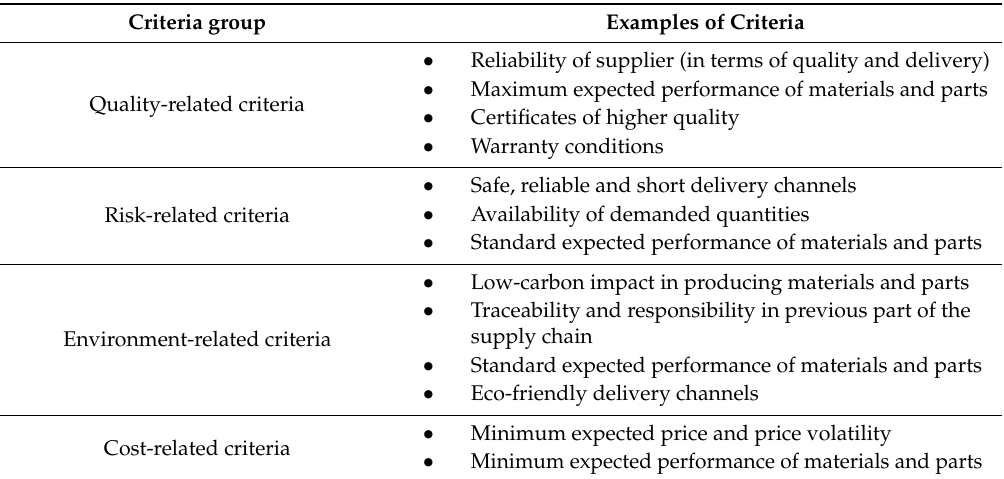
Table 1. Exclusion criteria groups and